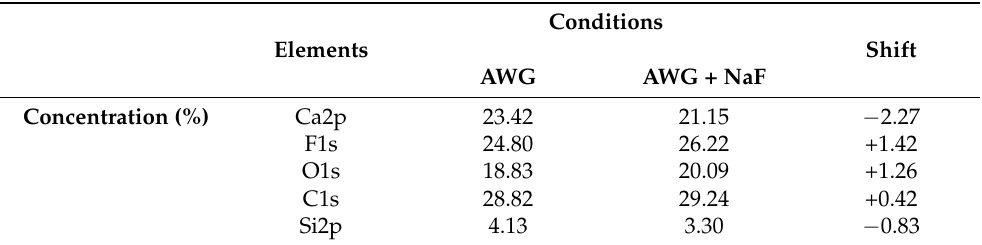
Table 4. Relative content of surface elements of fluorite treated with different reagents.